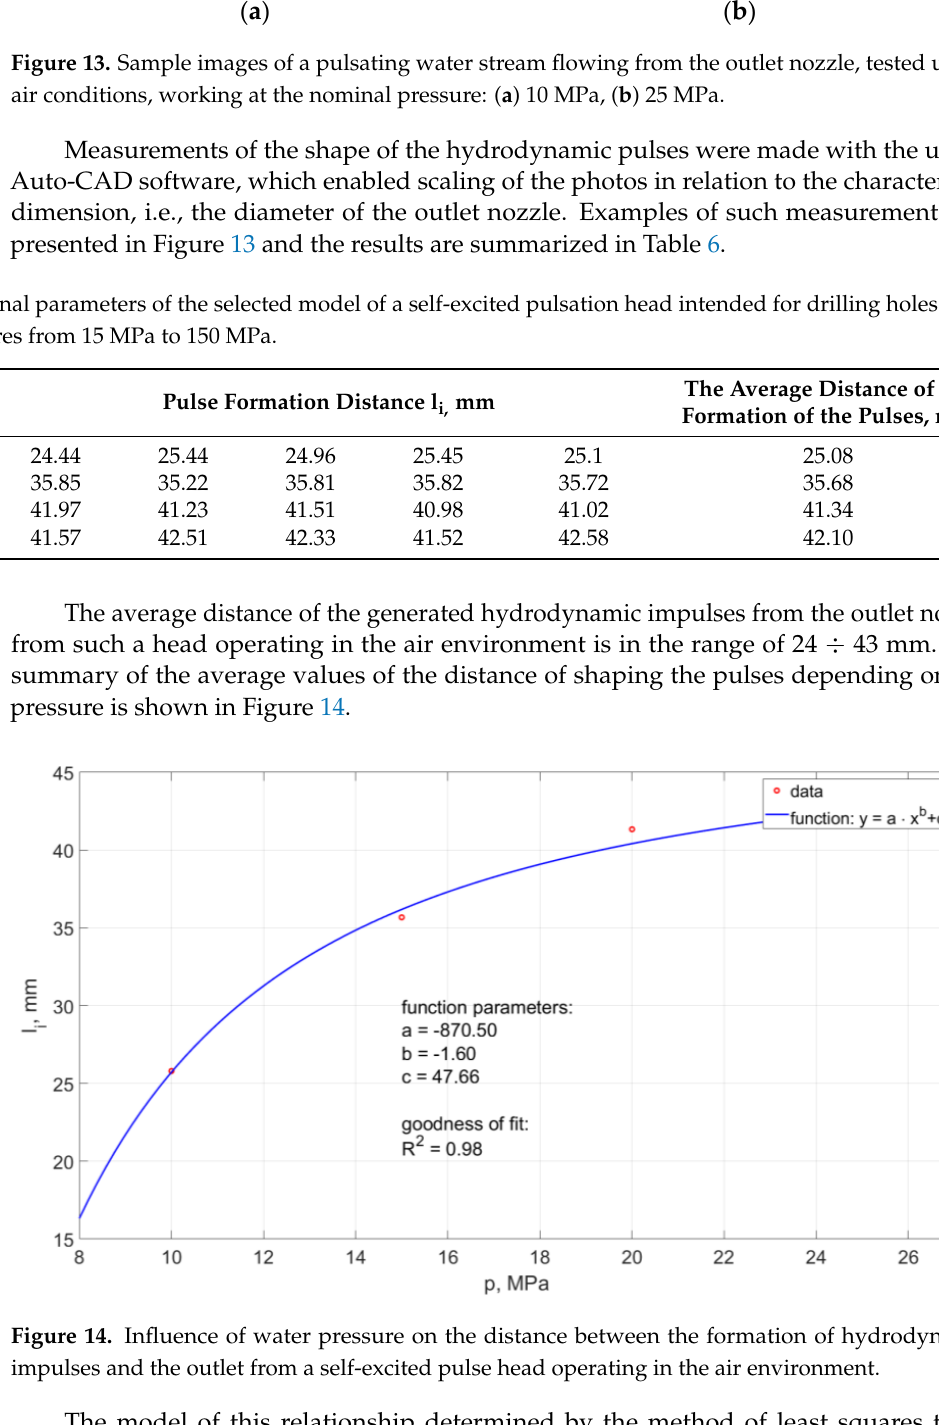
Figure 14. Influence of water pressure on the distance between the formation of hydrodynamic impulses and the outlet from a self-excited pulse head operating in the air environment. The model of this relationship determined by the method of least squares takes the form: The model determination coefficient is approximately R 2 = 0.98.